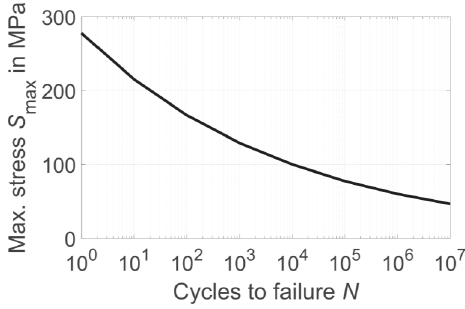
Figure 7. Tension fatigue curve of PAL 7130 [48].